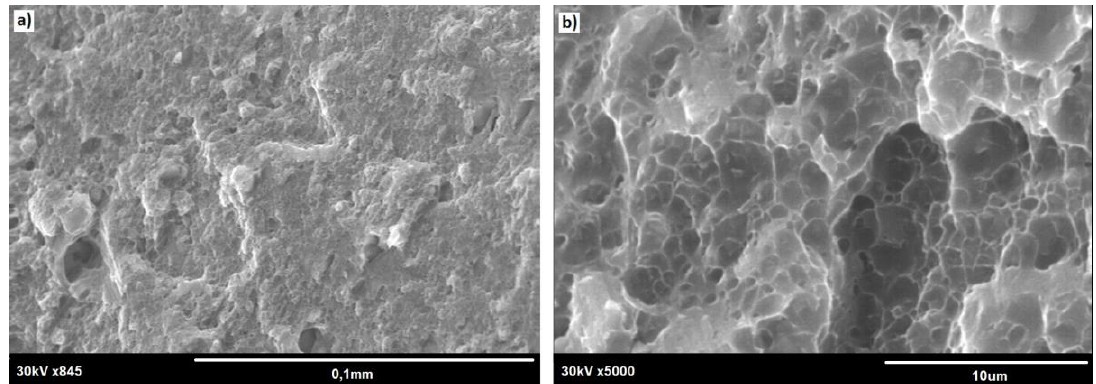
Figure 17. SEM image of fracture of E/224 rpm rod: view of the outer-zone area. ( a ) outer rim; ( b ) core